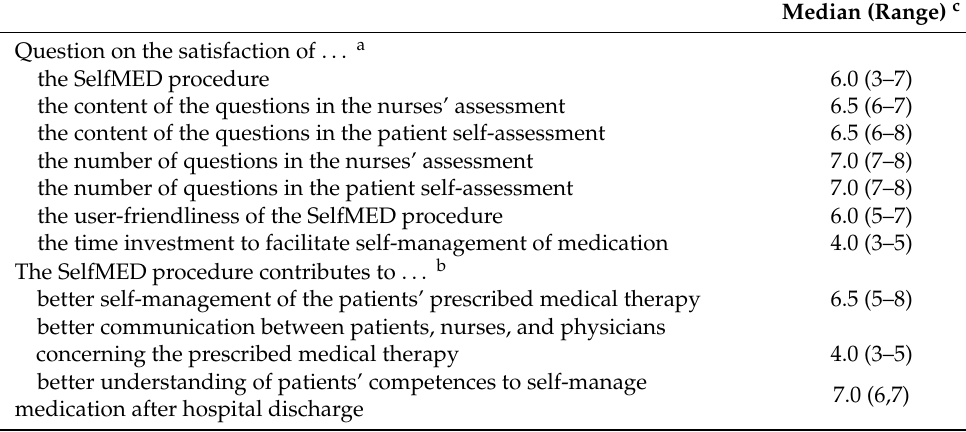
Table 4. Feasibility of the SelfMED procedure as reported by participating cardiologists (n =